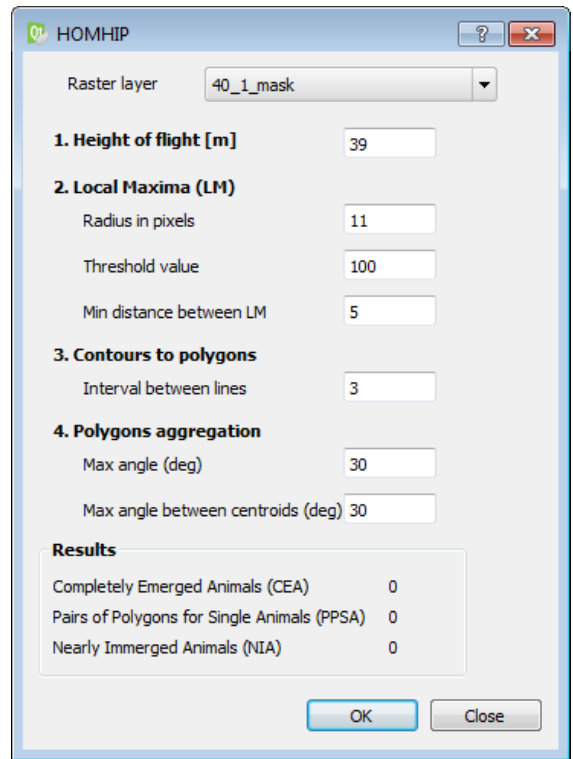
Figure 1: Graphical User Interface into QGIS for the specification of parameters and the presentation of results.